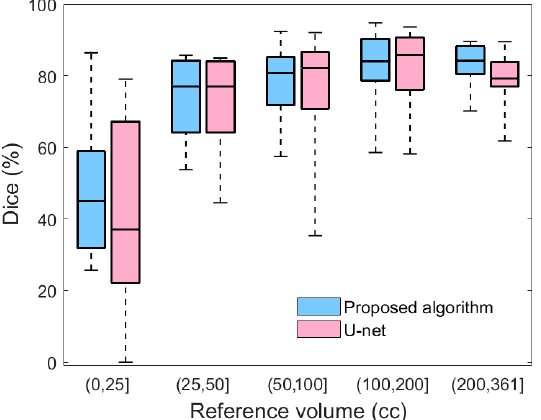
Figure 9. A box plot comparing the Dice similarity coefficients of the proposed algorithm and U-net with respect to the severity of hematoma.